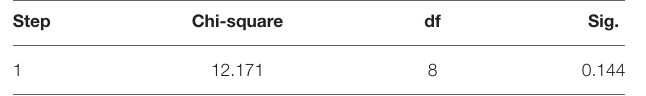
TABLE 11 | Hosmer and Lemeshow